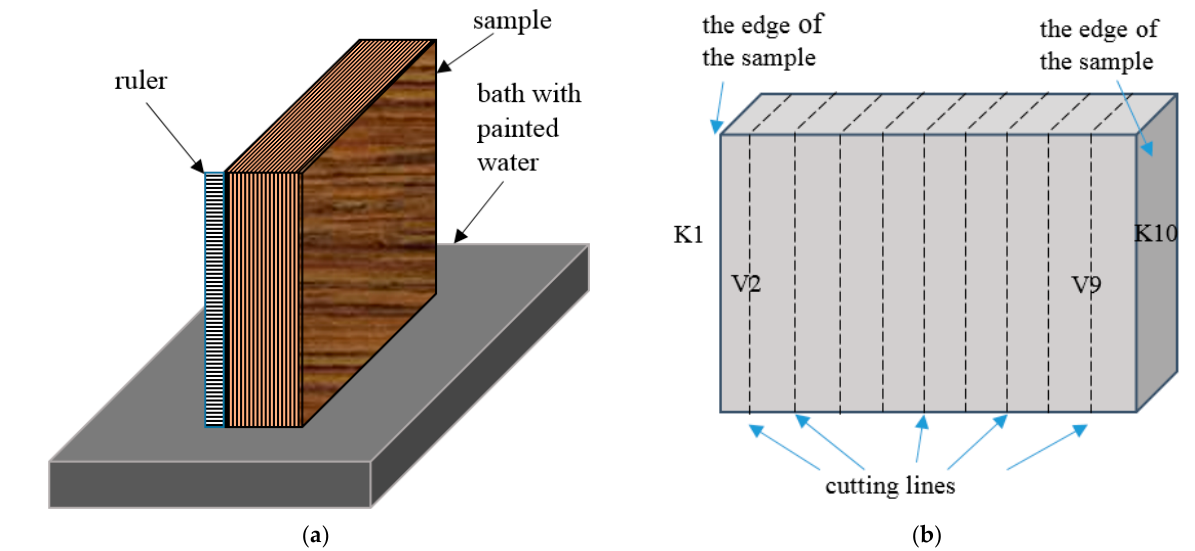
Figure 1. A determination of the height to which water rises in the sample: ( a ) measurement carried out at a fixed time after immersion; ( b ) after the test, the measurement is carried out after 24 h and 96 h, where K—the edges of the sample, V—inside of the sample. Bending and tensile strength tests were carried out in order to evaluate the influence of water on the mechanical properties of LVL panels. The bending test was carried out using a universal test machine, a BTI-FB 050 TN (Zwick, Shanghai, China). The bending strength was determined by applying a load to the center of the specimen which itself had been placed on two supports in accordance with EN 310 (Figure 2) [32]. F F